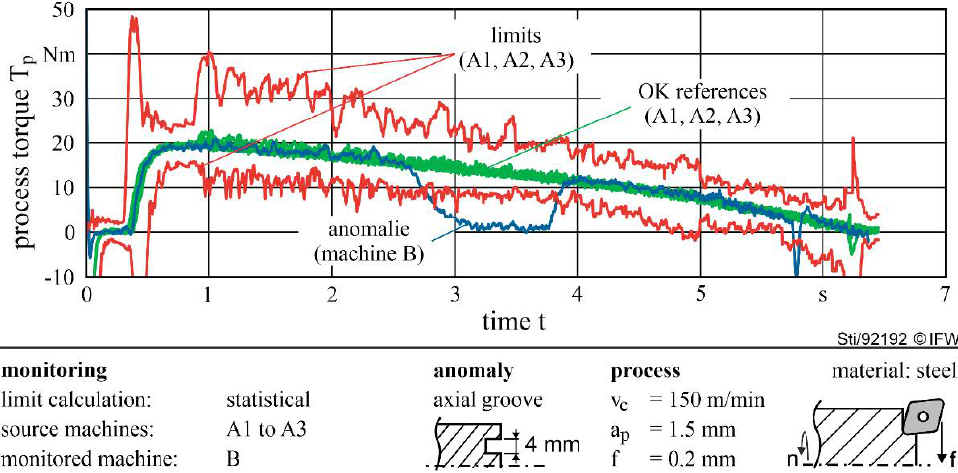
Figure 9. Transfer of monitoring limits among machines of different models.